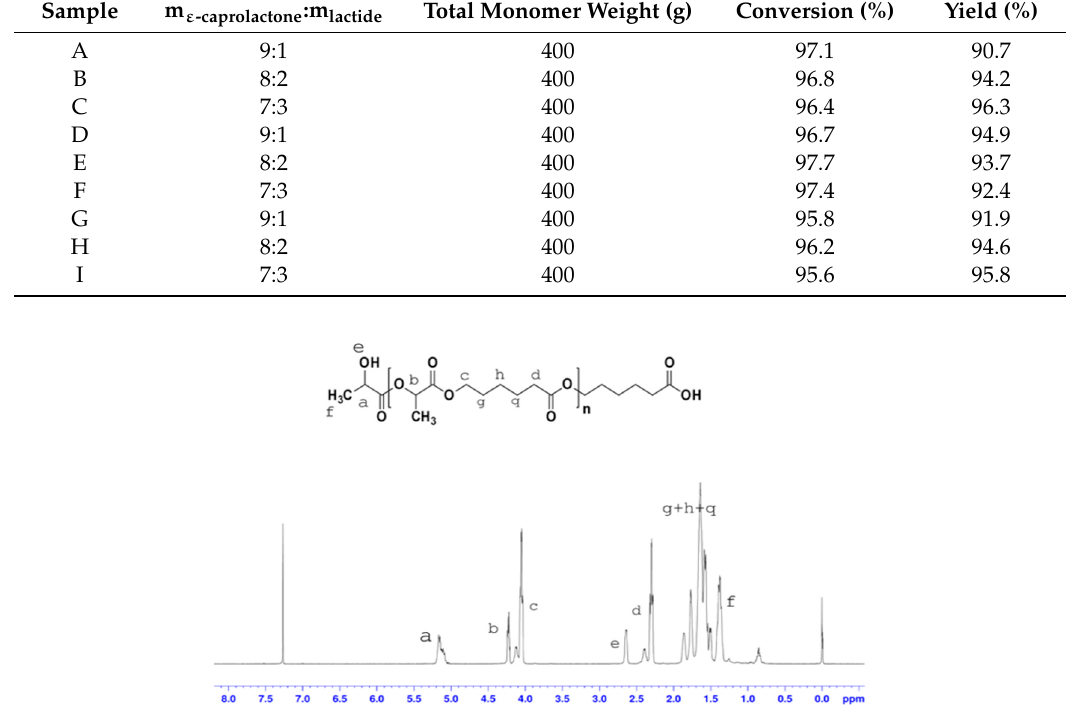
Figure 5. Protonic nuclear magnetic resonance ( 1 H-NMR) spectrum of the poly(lactide- ε -caprolactone) (P(LA-CL)) copolymer without glycol.